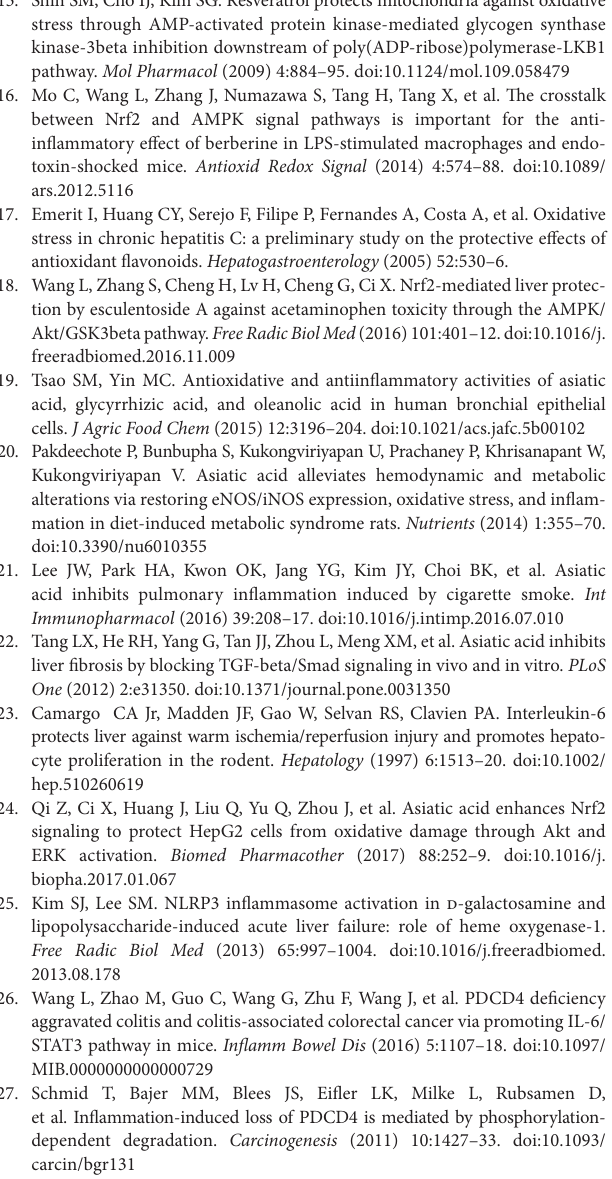
FigUre s1 | Effects of asiatic acid treatment on PI3K/AKT signaling pathway in L/D-induced fulminant hepatic failure. Liver tissues were collected from the mice 3 or 6 h after L/D challenge and analyzed by Western blotting. (a–c) Quantification of relative expression of P-PI3K/PI3K and P-AKT/AKT